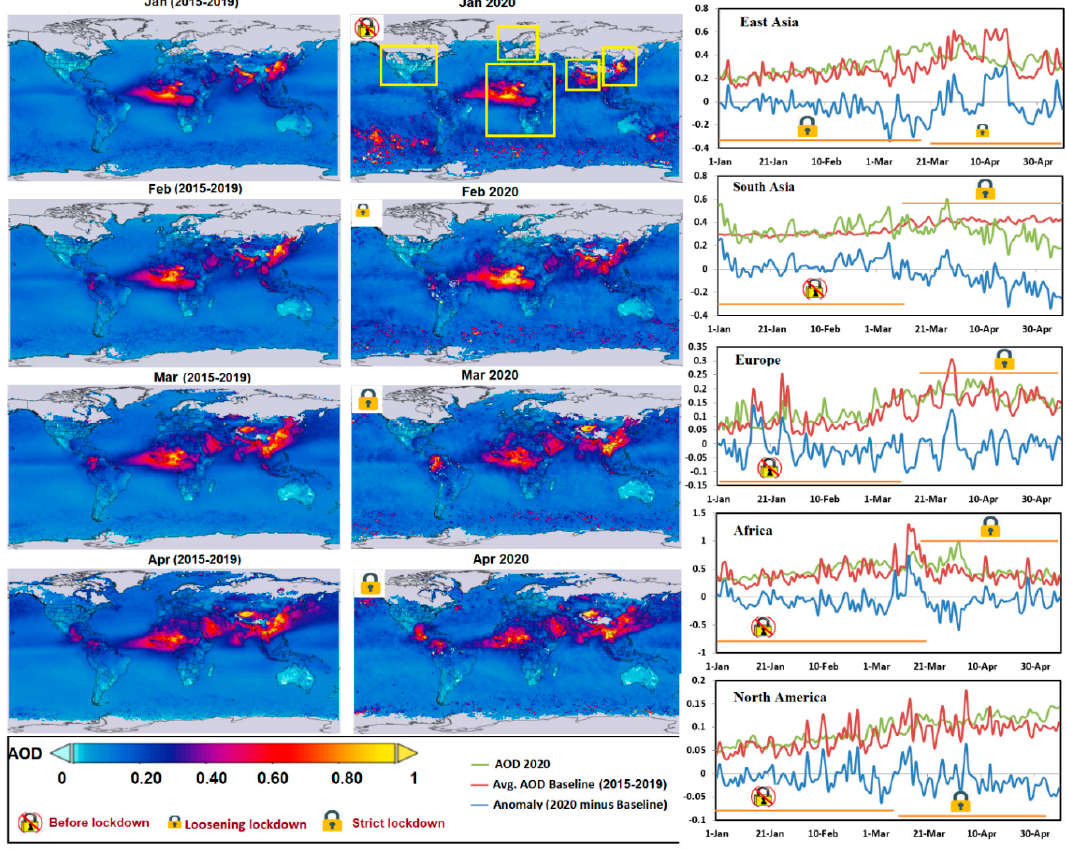
Figure 6. Spatial and temporal variations of aerosol optical depth (AOD) before and after the lockdown in 2020 compared with the baseline （ 2015–2019 ).